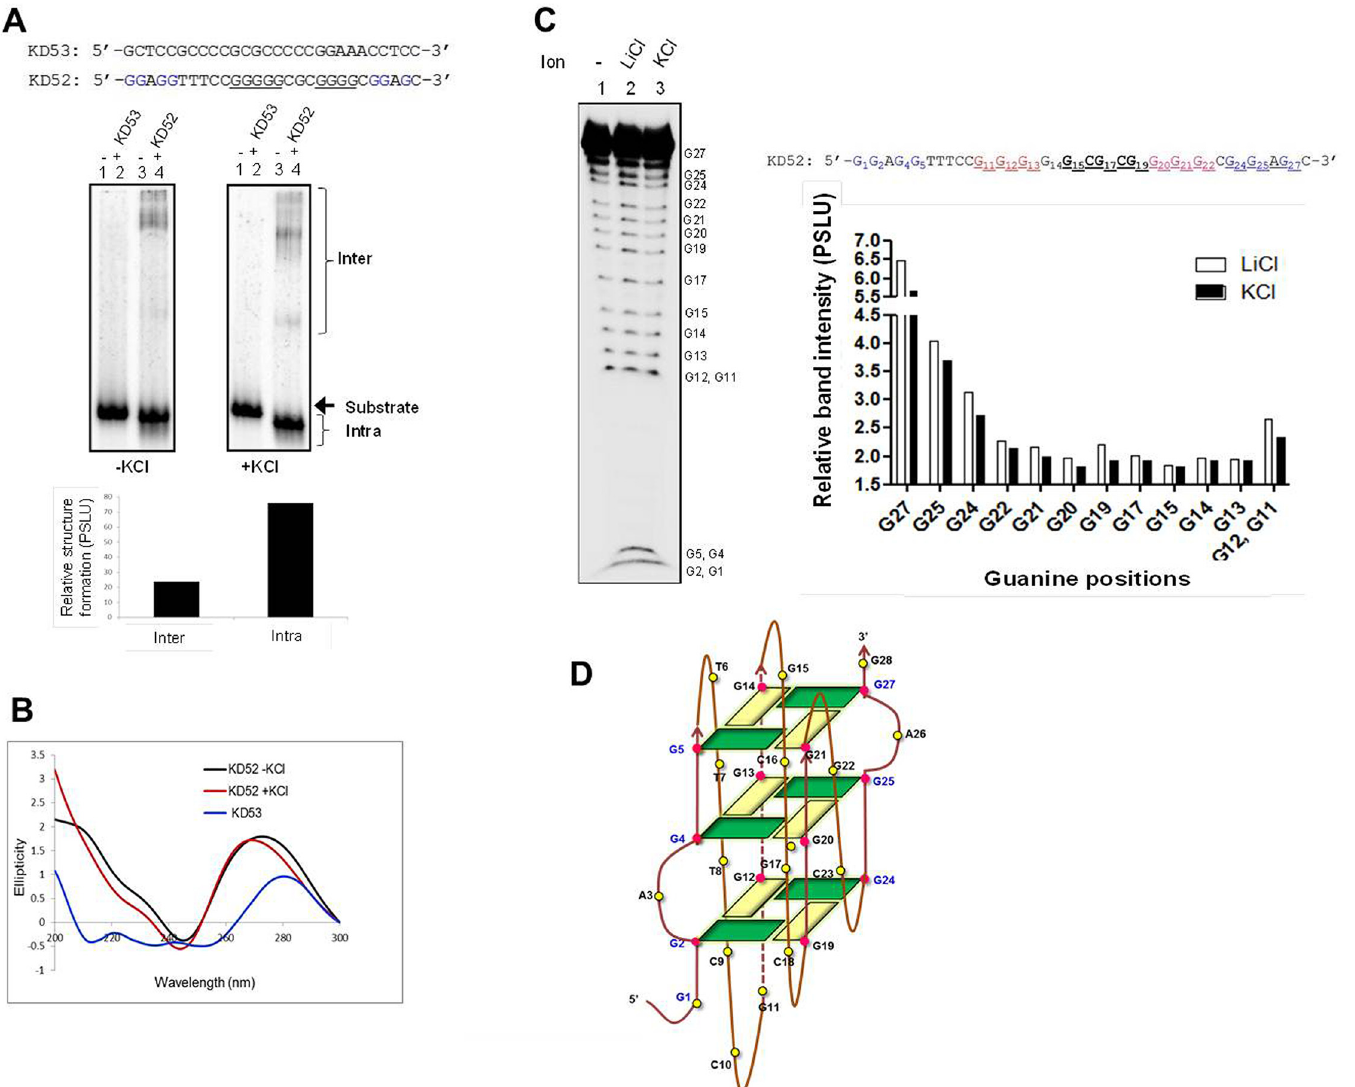
Fig 7. SHOX gene intramolecular G-quadruplex uses two GNG motifs for structure formation. (A) The oligomeric DNA sequence spanning portion of SHOX gene (KD52) and its complementary C rich strand (KD53). Native PAGE profile shows the formation of inter and intramolecular G-quadruplex in presence of KCl (100 mM). For other details, refer Fig 1 legend. Quantification for inter and intra G-quadruplex species are also shown. (B) CD analysis of KD52 and KD53 in presence of KCl (100 mM). (C) DMS assay on KD52. Radiolabelled KD52 was treated with DMS in presence of either KCl (100 mM) or LiCl (100 mM). Chemically modified DNA was then cleaved using piperidine and the reaction products were resolved on 15% denaturing PAGE (left panel). Quantification for individual guanine bands (in LiCl and KCl cases) is depicted in the right panel. Individual bands corresponding to each guanines were quantified from the lanes 2 and 3 using Multi Gauge and relative band intensities are plotted pairwise. (D) 2-D model showing potential intramolecular G- quadruplex formation on KD52.